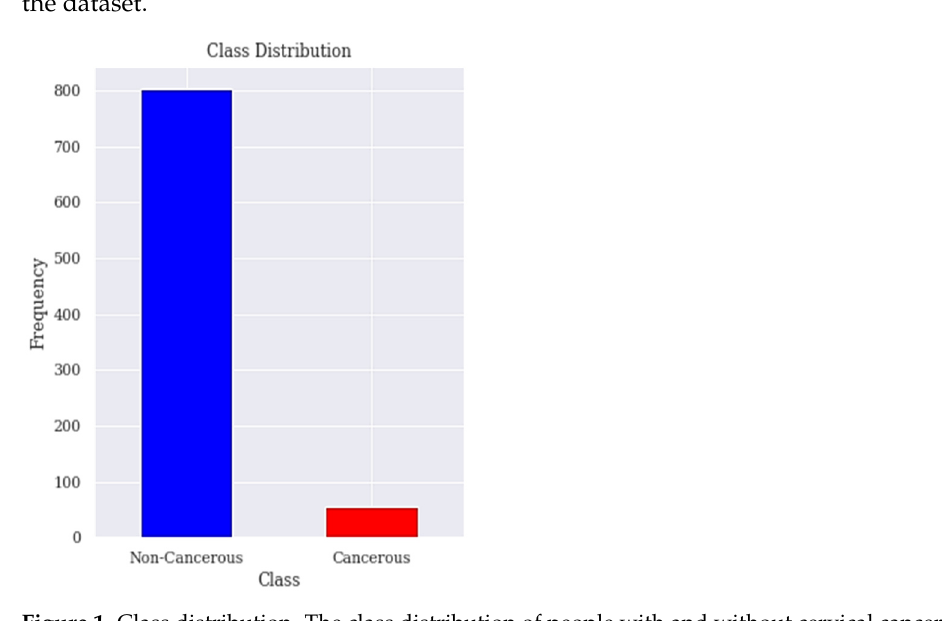
Table 1. Characteristics of Dataset.